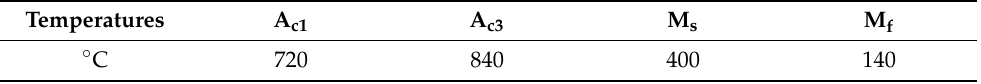
Table 2. Critical temperatures for the heat treatments of the steel samples, determined by dilatometry.